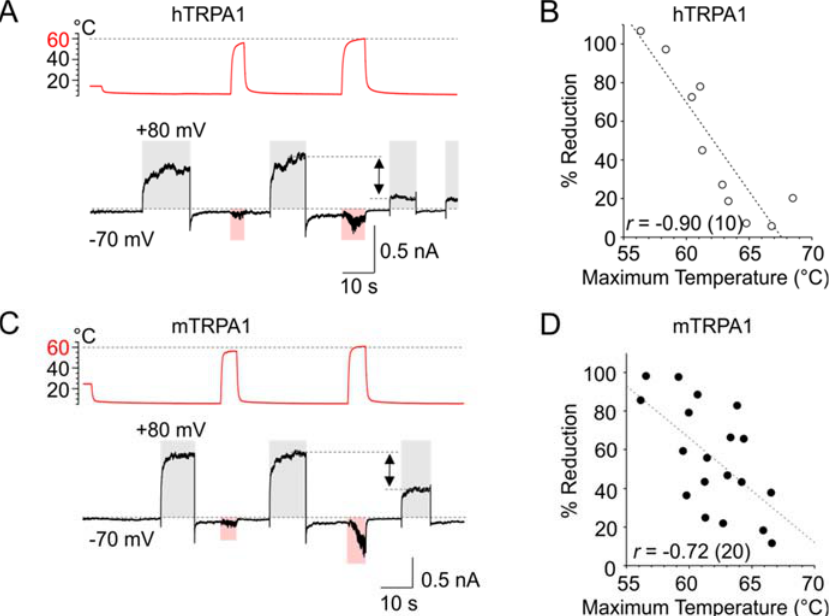
Figure 6. Temperatures above, but not below, 60 ◦ C impede voltage-induced activation. ( A ) Representative whole-cell currents of hTRPA1 in response to temperature (shaded pink area) and voltage (shaded grey area) steps. The temperature trace is shown above the records. Repetitive depolarization from − 70 to + 80 mV elicited outward currents that were strongly reduced only if the heat step exceeded 60 ◦ C. The time course of temperature changes (from 6 to 56 ◦ C and then to 61 ◦ C) is indicated above the record. The reduction is marked by arrow. ( B ) The degree of the reduction of voltage-induced currents was strongly correlated to the maximum temperature applied. ( C ) Representative whole-cell currents of mTRPA1 treated as in ( A ). ( D ) The current reduction of mTRPA1 was strongly correlated to the maximum temperature applied. The number of cells is indicated in brackets for each orthologue.